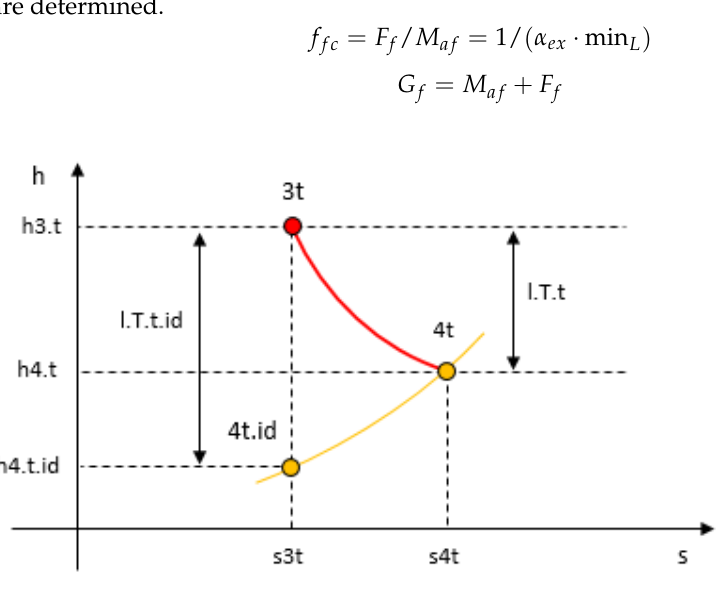
Figure 6. Expansion enthalpy–entropy diagram.